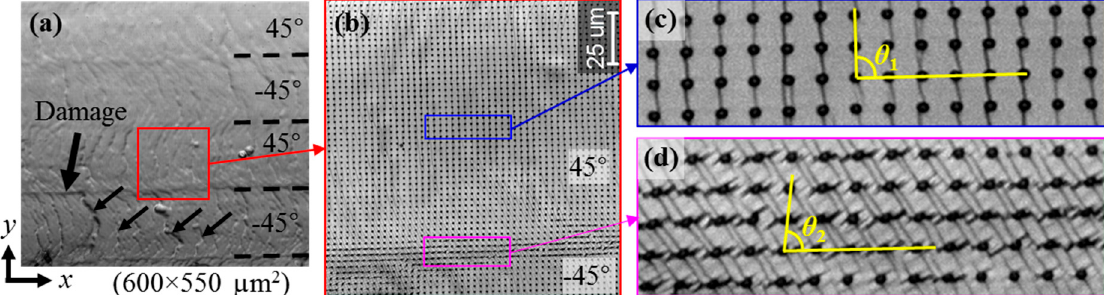
Figure 11. Recorded 2D grid images in ( a ) the analysis area and ( b ) a local area near the lower (45 ◦ / − 45 ◦ ) layer interface, and enlarged views ( c ) in the middle of 45 ◦ layer and ( d ) at the (45 ◦ / − 45 ◦ ) (45°/ − 45°) layer interface, and enlarged views ( c ) in the middle of 45° layer and ( d ) at the (45°/ − 45°) layer interface on CFRP at 327 MPa in the three-point bending layer interface on CFRP at 327 MPa in the three-point bending test.